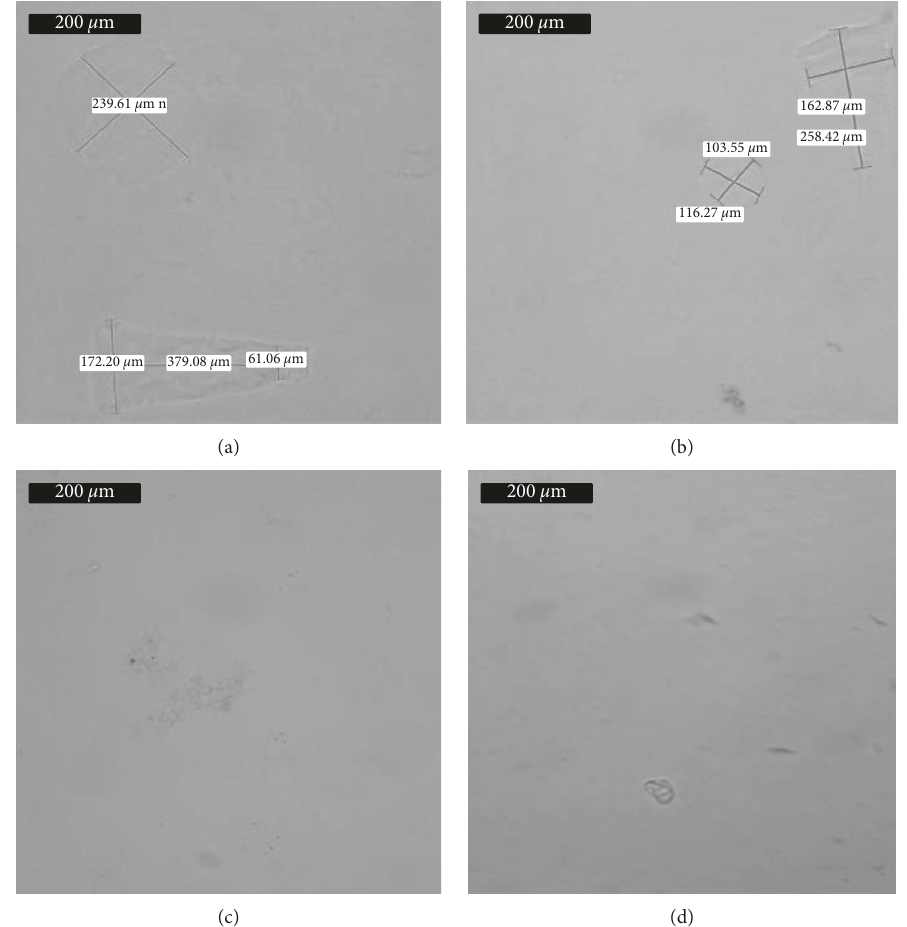
Figure 1: Optical micrographs of hydrogels made from CMC 2%: (a) ionotropic gelation with CaCl CaCl 2 4.9% w/v; (c) polyelectrolyte complexation with CS 0.01% w/v; (d) combination of ionotropic gelation and polyelectrolyte com- plexation (CaCl 2 1% w/w). Scale (a, b) 200x and (c, d)